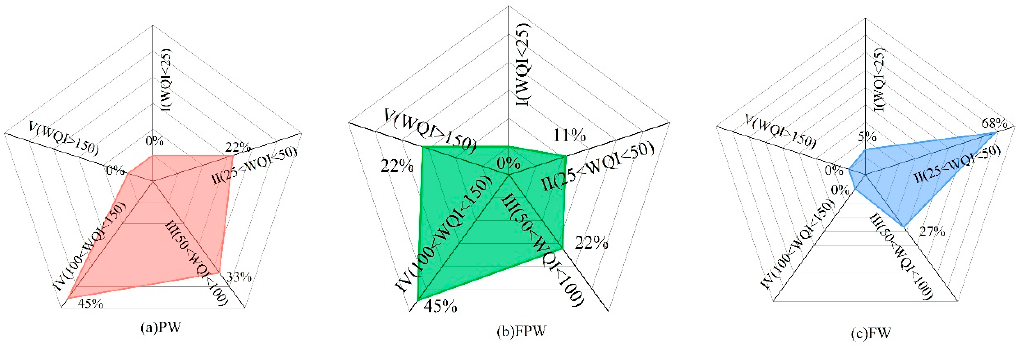
Figure 4. Radar maps of water quality of different groundwater types. ( a ) PW, ( b ) FPW, ( c ) FW.